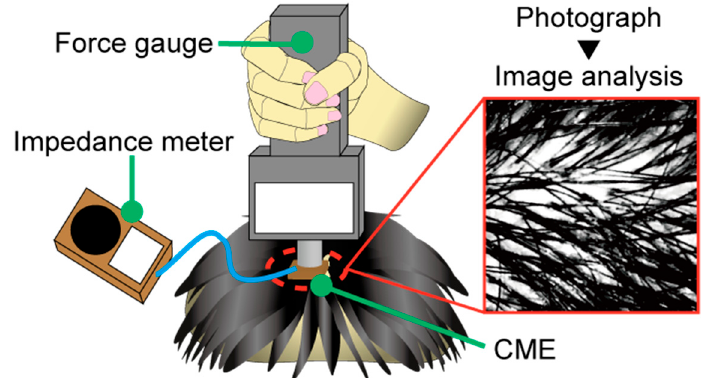
Figure 6. Image of the hair occupancy test. The CME was manually pressed against the scalp with a force gauge. The impedance was recorded with a meter. An example of an analyzed image of the hair occupancy rate is shown.